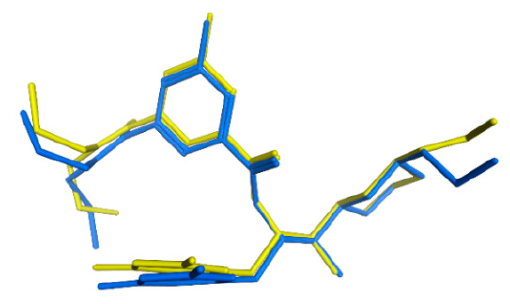
Figure 6. Self-docking validation. Superposition of the best-docked pose of ChEMBL257278 (0.544 Å) (blue) with its crystal structure conformation (yellow). (blue) with its crystal structure conformation (yellow).